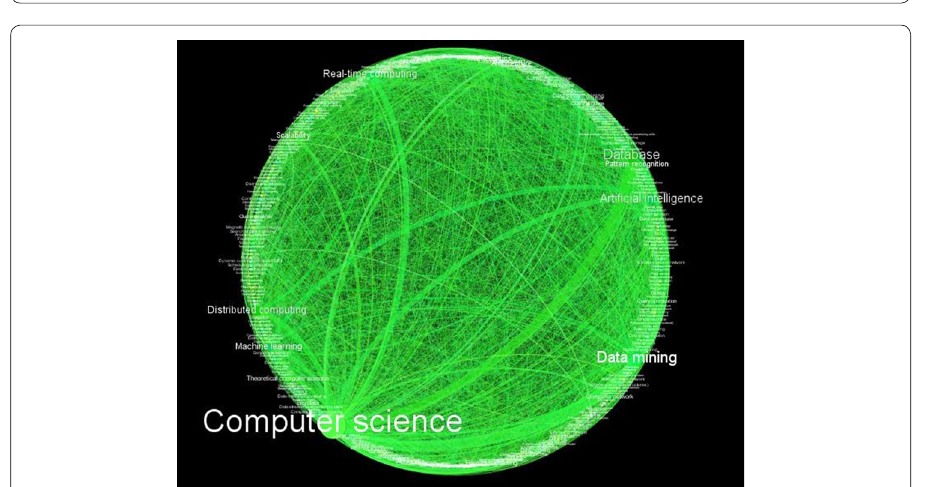
Fig. 17 Network of scientific fields of studies of the scholarly works cited by the